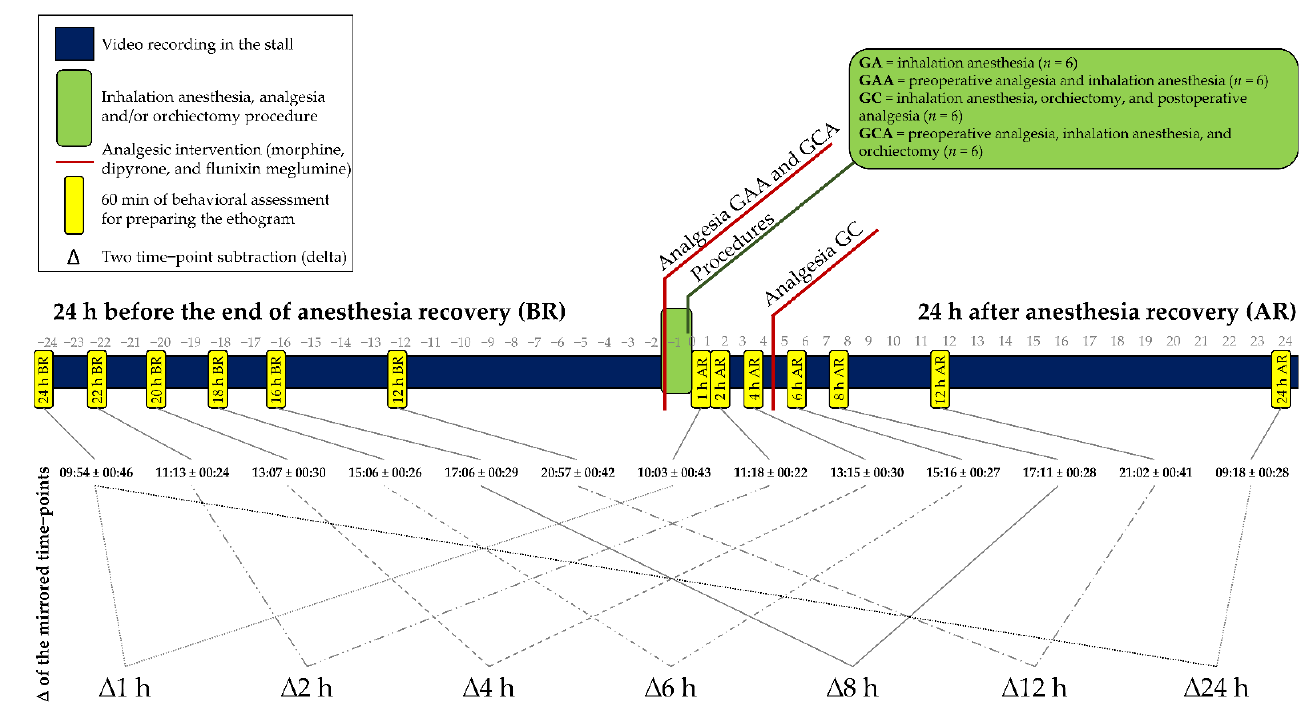
Figure 1. Timeline containing the 60-min behavior recording time-points, anesthetic, analgesic, surgical interventions, and identification of the mirrored time-points for extraction of the deltas. The delta ( ∆ ) is the subtraction of the frequency and duration of the behaviors recorded after the anesthesia from those recorded in the mirrored hours before the anesthesia.